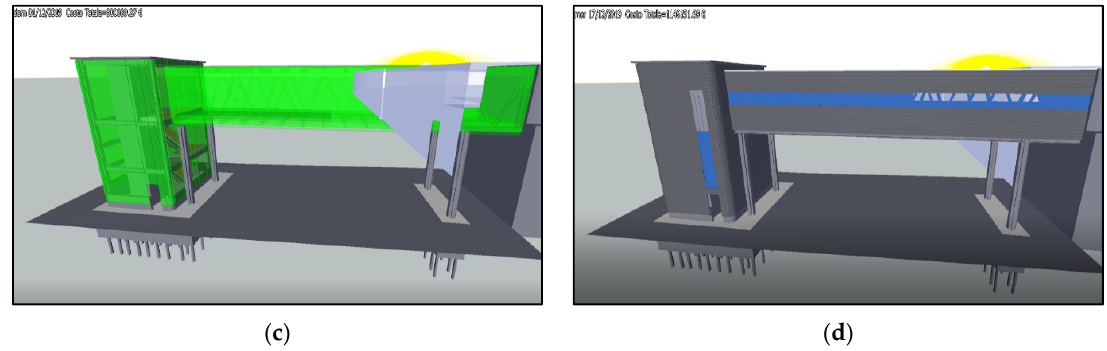
Figure 9. Simulation work and progress: ( a ) elevation structures; ( b ) reticular structure; ( c ) bridge structure; ( d ) finishing works.